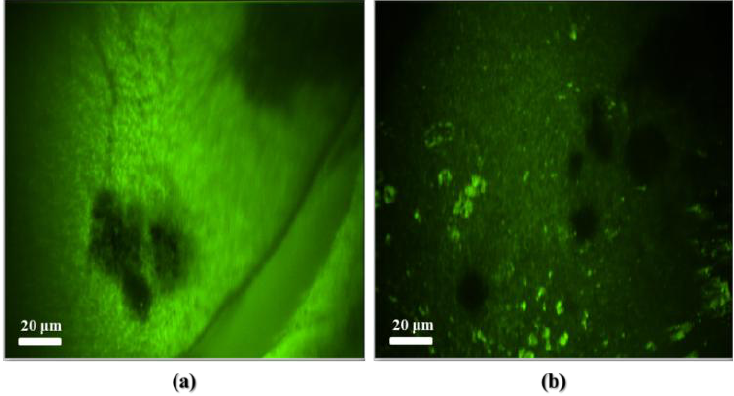
Figure 9. Fluorescence images of neuroblastoma cells on the PCB MEA of ( a ) side part and ( b ) center part.